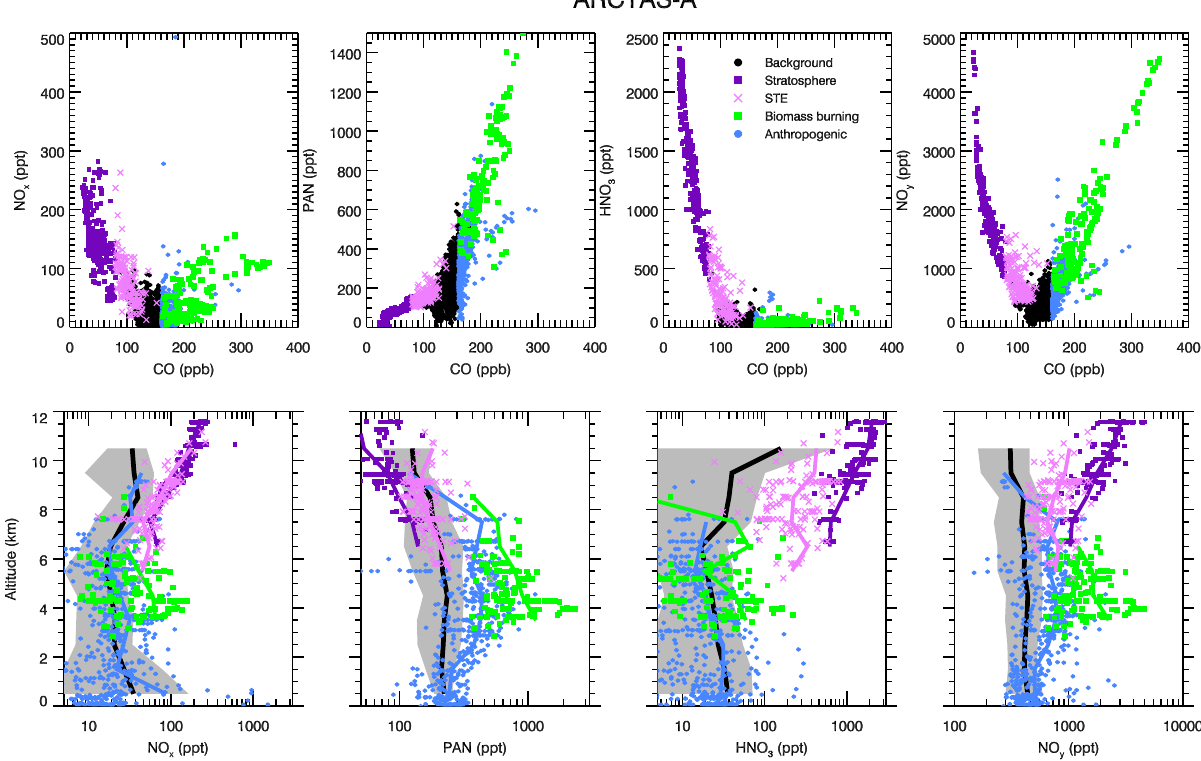
Fig. 4. Top panels: Scatter plots of NO x , PAN, HNO 3 , and NO y vs. CO during ARCTAS-A. Bottom panels: Similar to Fig. 3, but for 1-km binned verticle profiles of NO x , PAN, HNO 3 , and NO y during ARCTAS-A. Background air is shown in black with the other air masses highlighted in color: stratosphere (purple), stratosphere-troposphere mixed (lilac), anthropogenic pollution (blue) and biomass burning